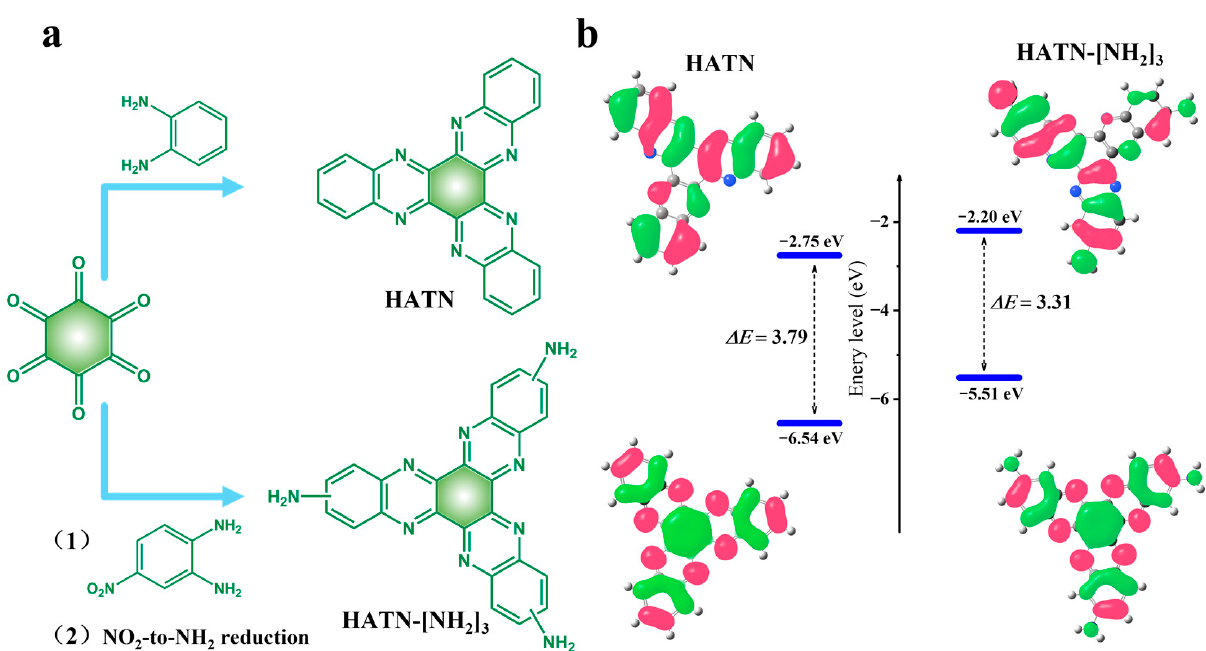
Figure 1. ( a ) Schematic illustration for the synthesis of HATN-[NH 2 ] 3 and HATN. The synthesis of HATN-[NH 2 ] 3 includes two steps: (1) the reactant of 4-Nitro-o-phenylenediamine and HKH, and (2) the NO 2 -to-NH 2 reduction. ( b ) Molecular structures and HOMO/LUMO energy levels of HATN-[NH 2 ] 3 and HATN.